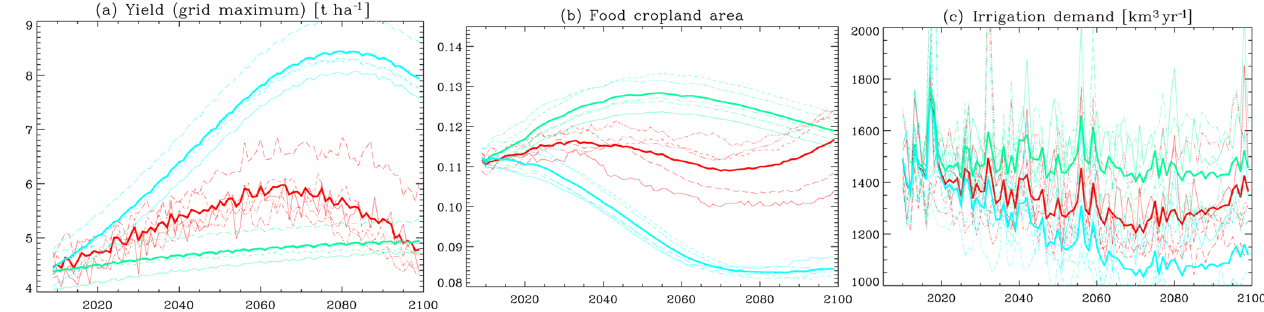
Figure 16. Time series of changes in (a) cropland yield (maximum across five crops in each grid, tha − 1 ), (b) food cropland area (a fraction of total land area), and irrigation demand (km 3 yr − 1 ) based on the forcings of the five climate models under the RCP8.5 scenario. Simulations with climatic factors and CO 2 concentrations fixed at 2006 (light green, noCL + noFE), those with climatic factors fixed (cyan, noCL + FE), and those with varying climate and CO 2 concentrations (red, CL +